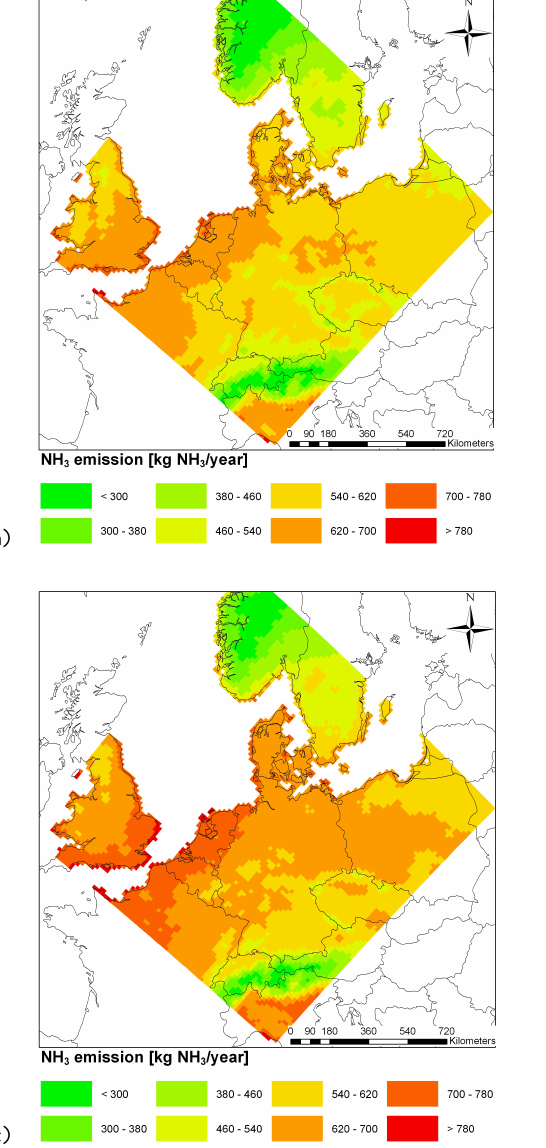
Fig. 3. Annual emission from storage facility in a pig farm with 1000 animals using average Danish production methods and exposed to different European climatic conditions in the years (a) 2047, (b) 2050, (c) 2087, (d) 2090,